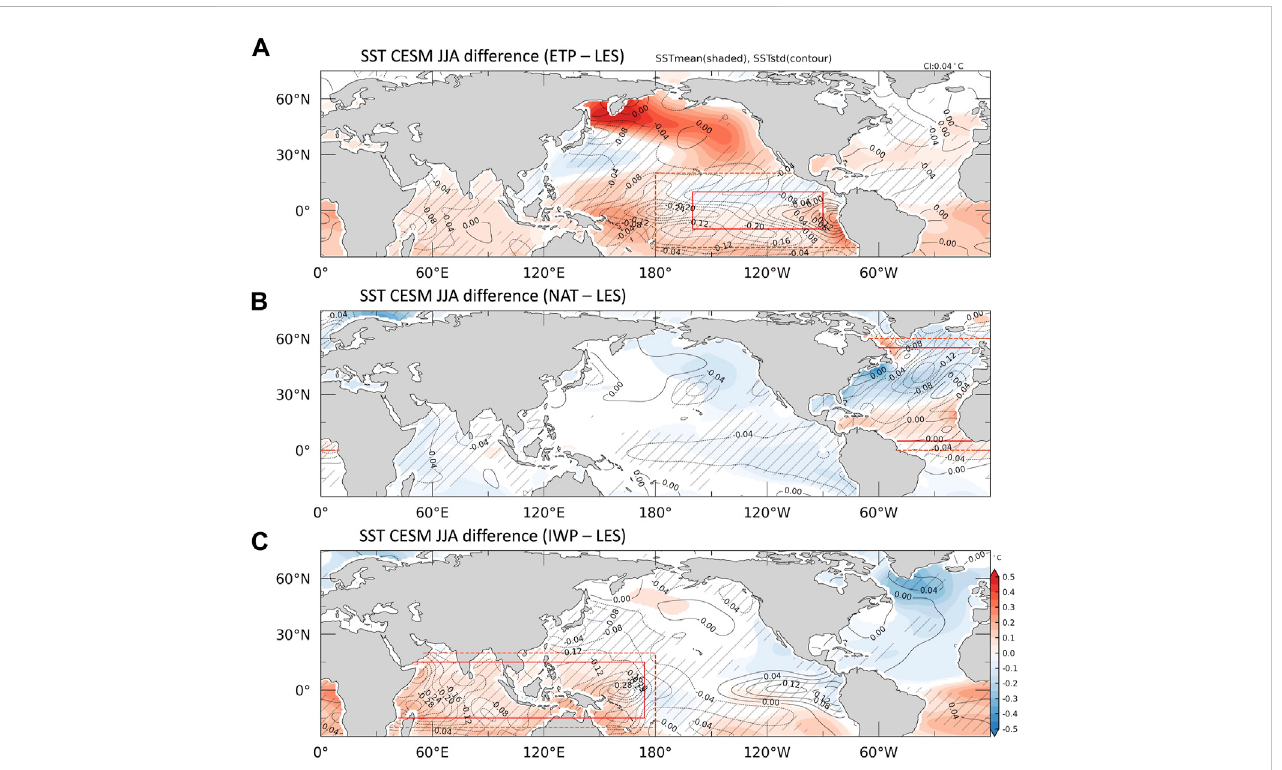
FIGURE 1 The SST mean (shaded) and standard deviation (contour) difference between pacemaker experiments and CESM_LES (pacemaker subtracts CESM_LES) in June — August (JJA) for (A) CESM_ETP, (B) CESM_NAT, and (C) CESM_IWP. The shading (hatching) donates regions in which the mean (standard deviation) difference is signi fi cant at the 95% con fi dence